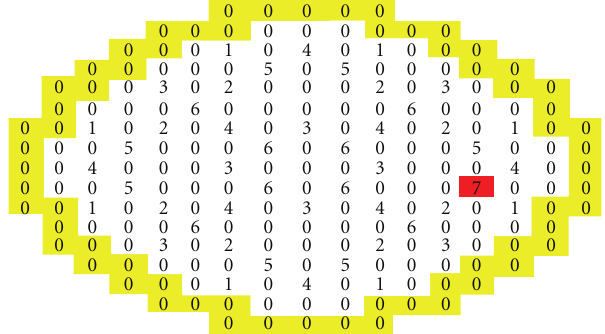
Figure 4: Control rod banks configuration.